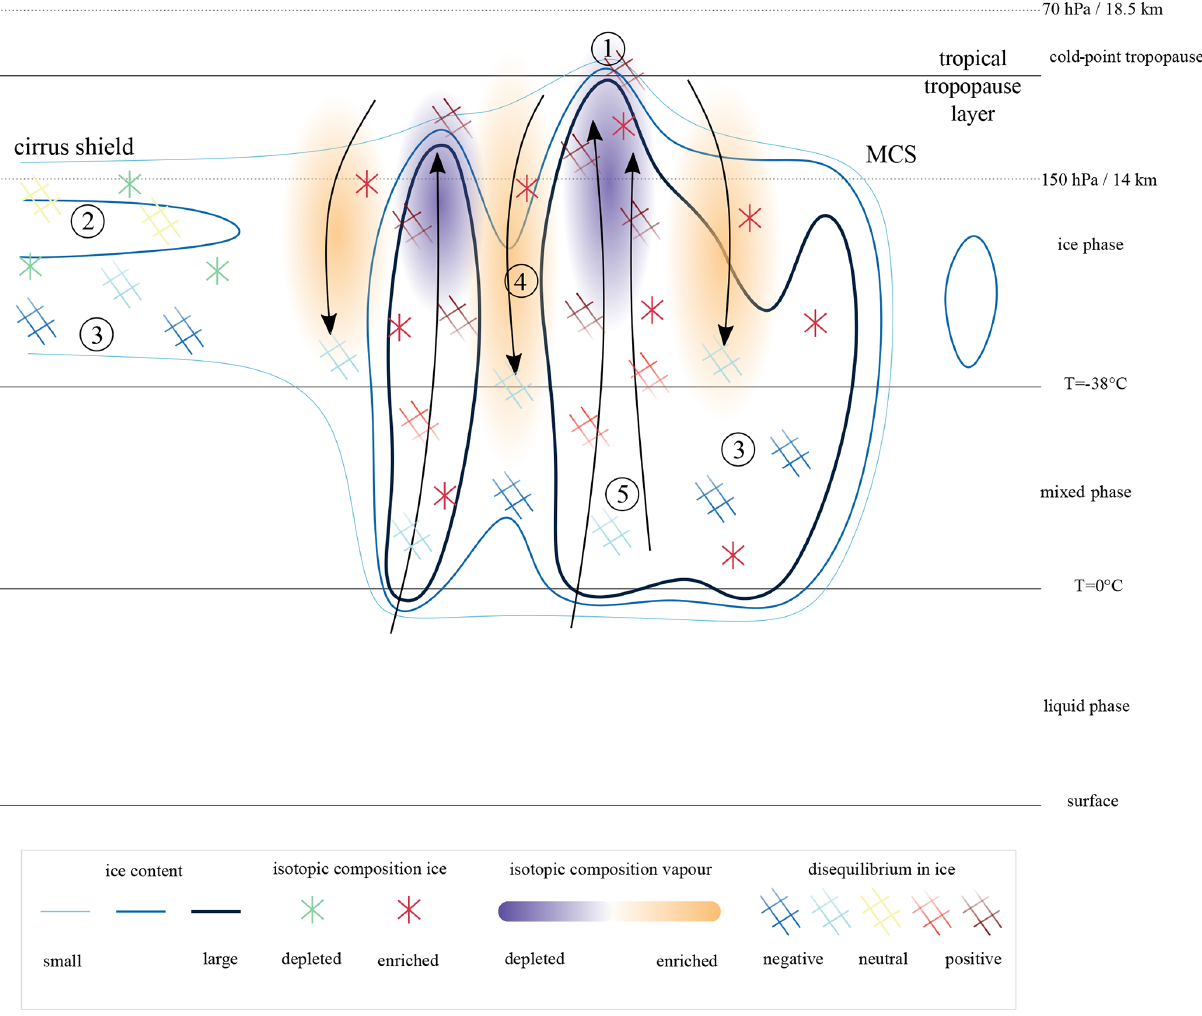
Figure 17. Schematic representation of the five key processes related to the formation and decay of tropical ice clouds: (1) convective lofting of very enriched ice along with the isotopic depletion of vapour through the preferential condensation and deposition of heavy isotopes in the updraughts, (2) in situ formation of ice under equilibrium fractionation in cirrus shields, (3) sedimentation and sublimation of ice in the mixed-phase cloud layer of convective systems and underneath cirrus shields, (4) non-fractionating sublimation of ice in convective downdraughts that enriches the environmental vapour, and (5) freezing of liquid water in the lower parts of convective updraughts. These processes are reflected by stable water isotope signals in ice, vapour, and especially the disequilibrium in ice ( (cid:49)δ 2 H ice ), as indicated by the legend. See the text for